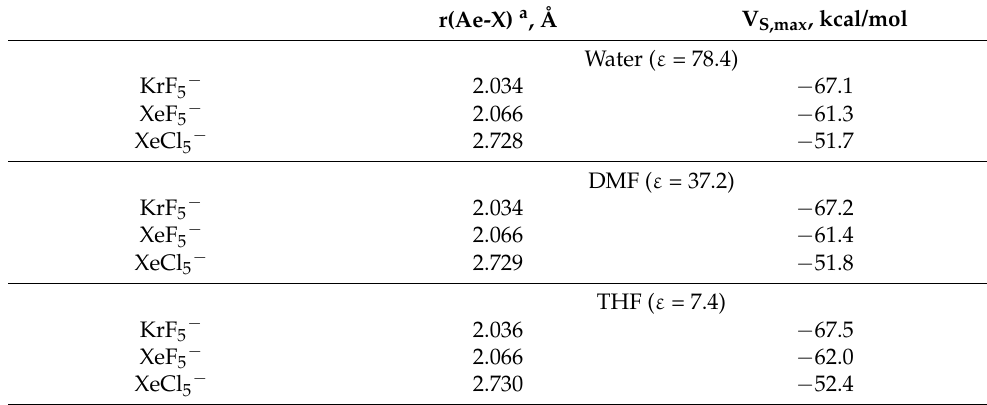
Figure 1. MEP of XeF 5 − on its 0.001 au isodensity surface at the MP2/aug-cc-pVDZ level. Color scale ranges from − 0.13 (blue) to − 0.11 (red) au. Table 1. Ae-X bond lengths in AeX 5 − monomers and maximum on the ρ = 0.001 au isodensity surface calculated at the MP2/aug-cc-pVDZ level of theory in different